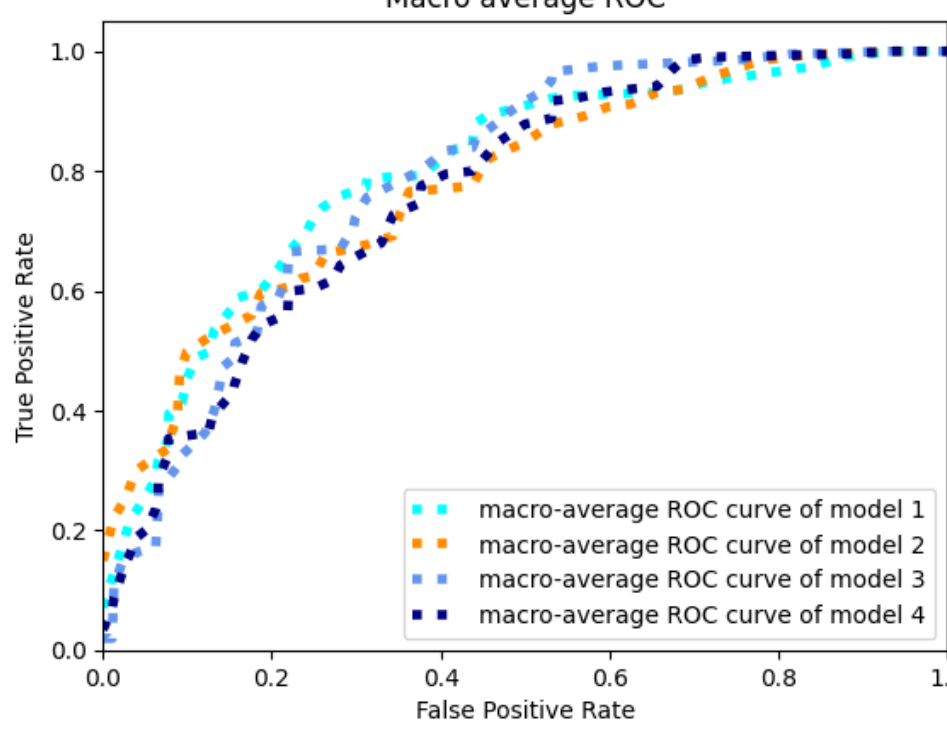
Figure 5. ROC curves on the test set. All the models performed similarly on unseen data. Examination of other metrics provides deeper